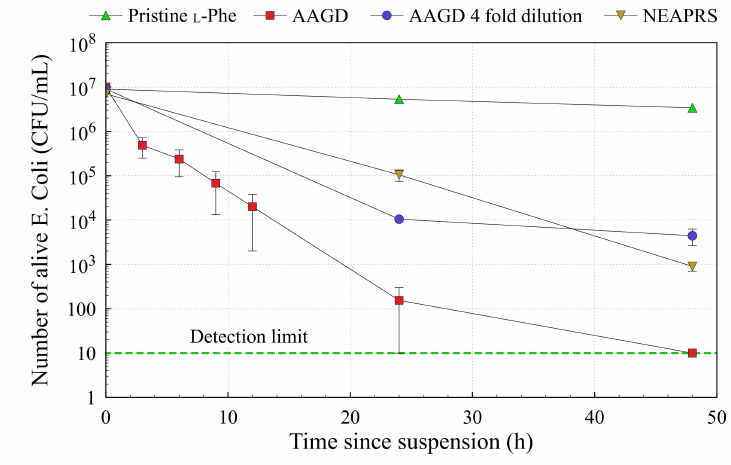
Figure 7. Viability of E. coli incubated in pristine L -Phe, L -Phe treated with AAGD, and L -Phe treated with oxygen radicals using nonequilibrium atmospheric-pressure radical source (NEAPRS) [18] as function of incubation